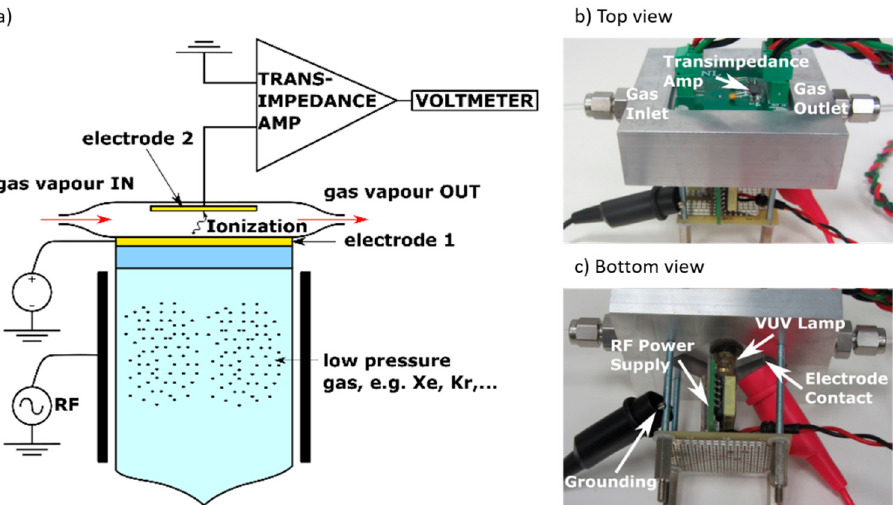
Figure 1. ( a ) PID sensor schematic lay-out; ( b ) PID sensor set-up aluminum block with gas inlet and outlet along with electronics circuit board comprising electrode 2 and transimpedance amplifier circuit; ( c ) VUV lamp comprised electrodes conveying excitation electric power to a miniature Kryp- ton-filled VUV